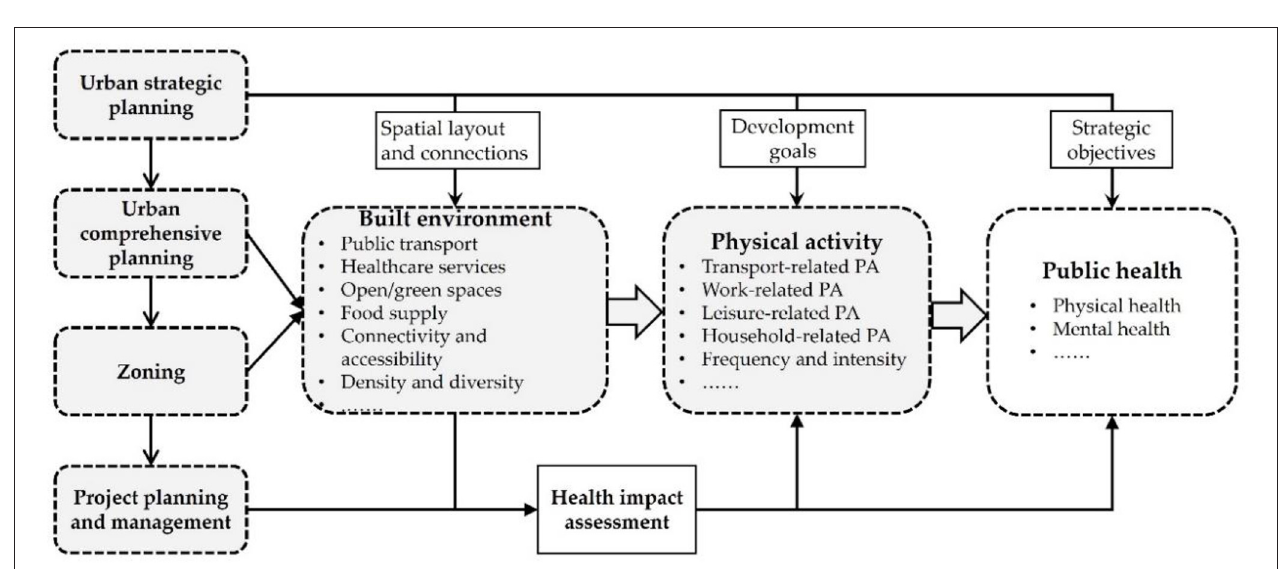
FIGURE 6 | Integration of built environments and public health for a healthy community and city.